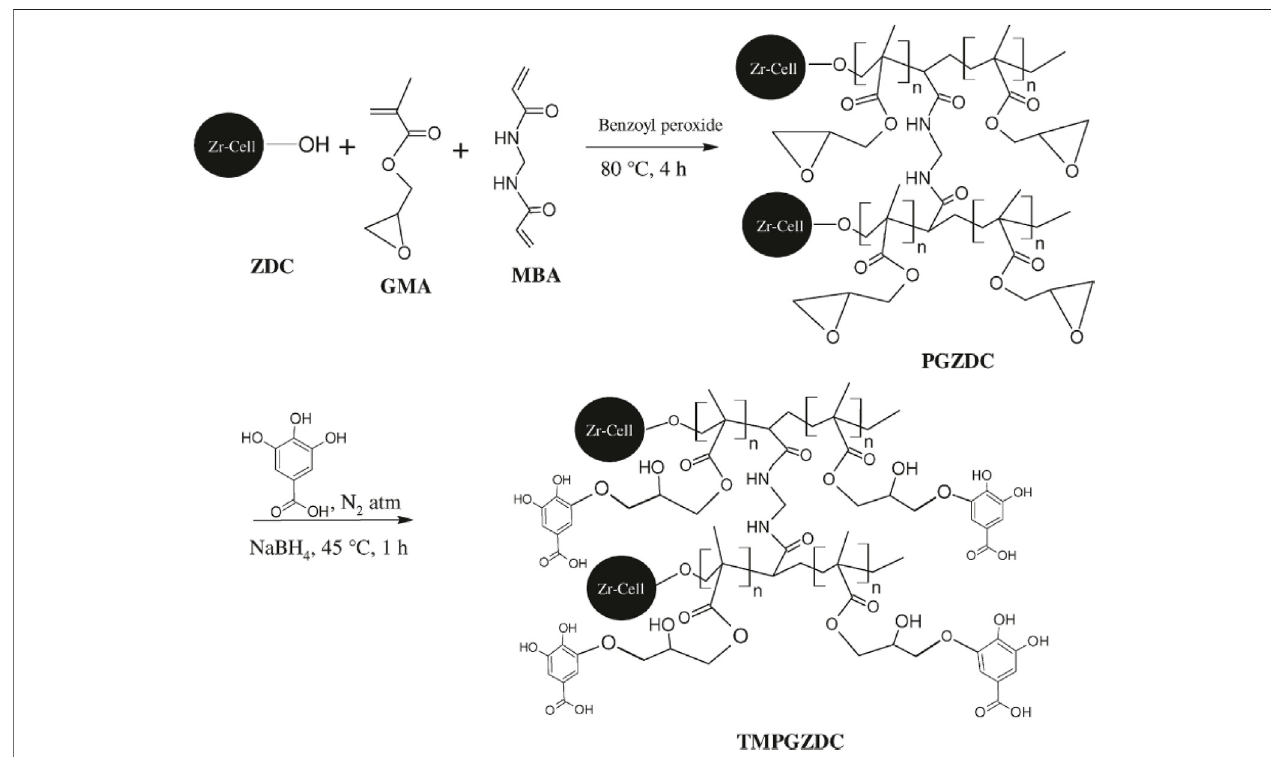
FIGURE1| Proposedreactionmechanismforthesynthesisoftannin-modi fi edpoly(glycidylmethacrylate)-graftedzirconiumoxidedensi fi edcellulose(TMPGZDC): zirconium oxide densi fi ed cellulose (ZDC) grafted with glycidylmethacrylate (GMA), N,N0-methylenebisacrylamide (MBA), and poly (glycidylmethacrylate)-grafted zirconium oxide densi fi ed cellulose (PGZDC) (Anirudhan and Rejeena, 2011).